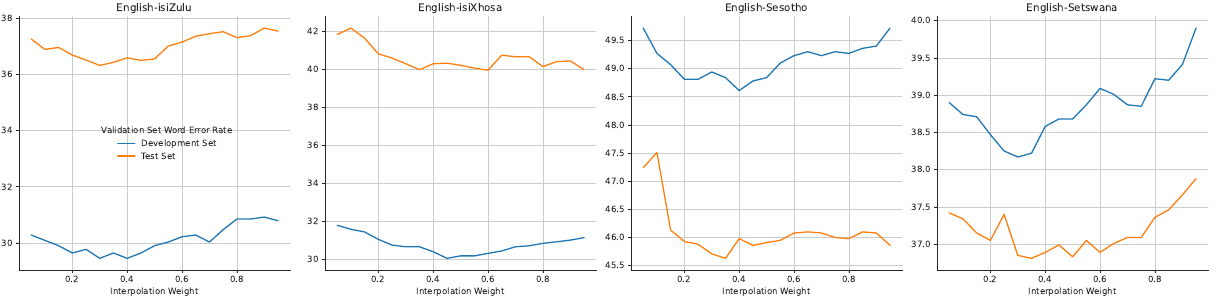
Figure 3. Development and test set word error rates (WER) for each of the respective language pairs (English–isiZulu, English–isiXhosa, English–Sesotho, and English–Setswana) when optimising the interpolation weight between N-best scores produced by the optimal pre-trained LSTM (N-LM M from Section 5.1) and BERT (M-BERT ( F - P ) from Section